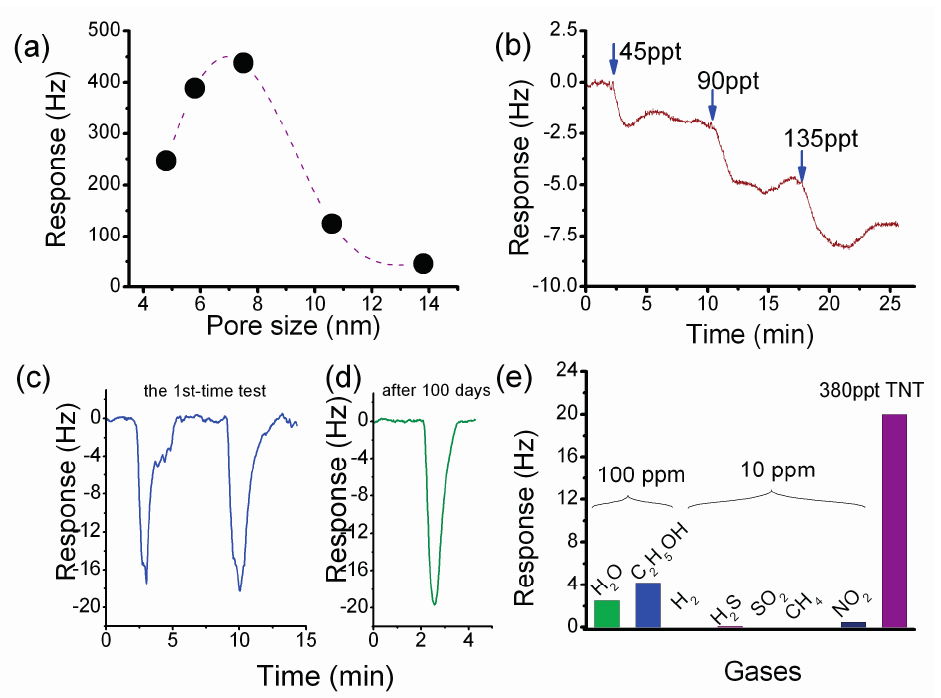
Figure 10. ( a ): Tested effect of pore-size on TNT detection sensitivity; ( b ): Typical sensing response of the functionalized HFMS sensor versus various TNT concentration of 45, 90 and 135 ppt; ( c ): Short-term repeatable and rapidly reversible sensing response to 380 ppt TNT; ( d ): After storing of 100 days, next-time detection with the same sensor shows satisfactory stability in sensitivity; ( e ): Response of the TNT sensor to various kinds of 10–100 ppm interfering gases compared with that to 380 ppt TNT. Reprinted with permission from